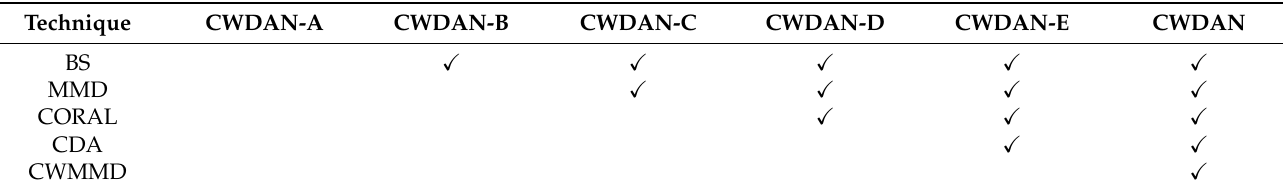
Table 6. Ablation experiments.